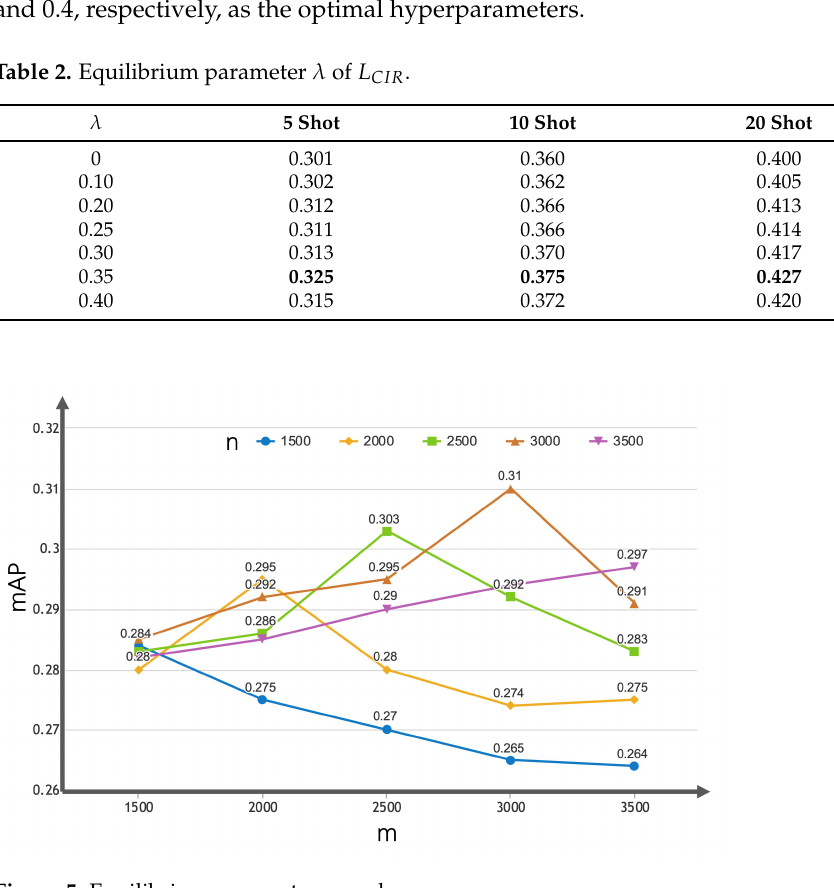
Figure 5. Equilibrium parameter m and n